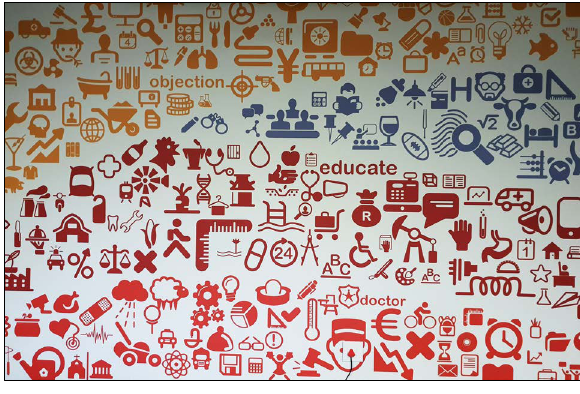
Wall art in a boardroom of the Faculty of Science at a leading tertiary institution. The image was captured in